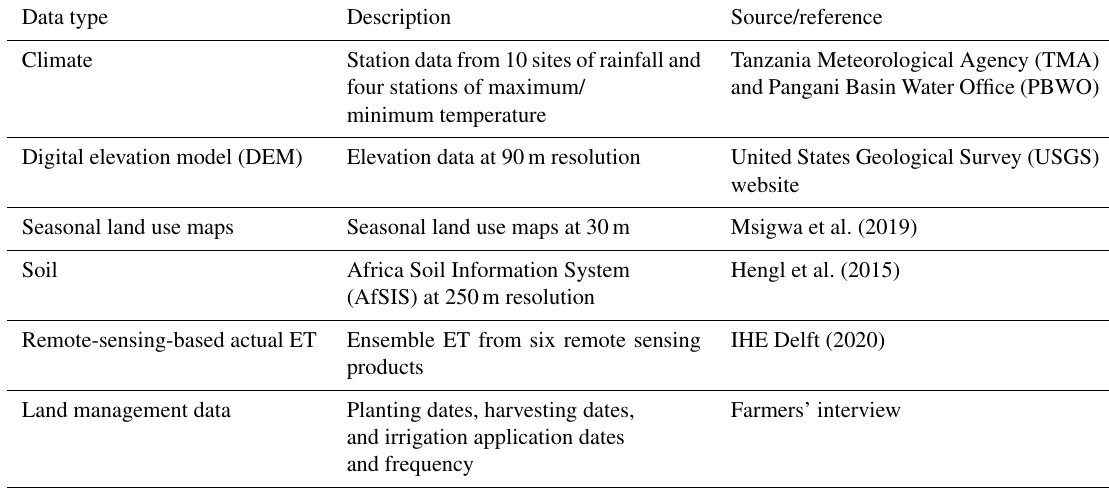
Table C1. Summary of the different data used in the study, together with description and